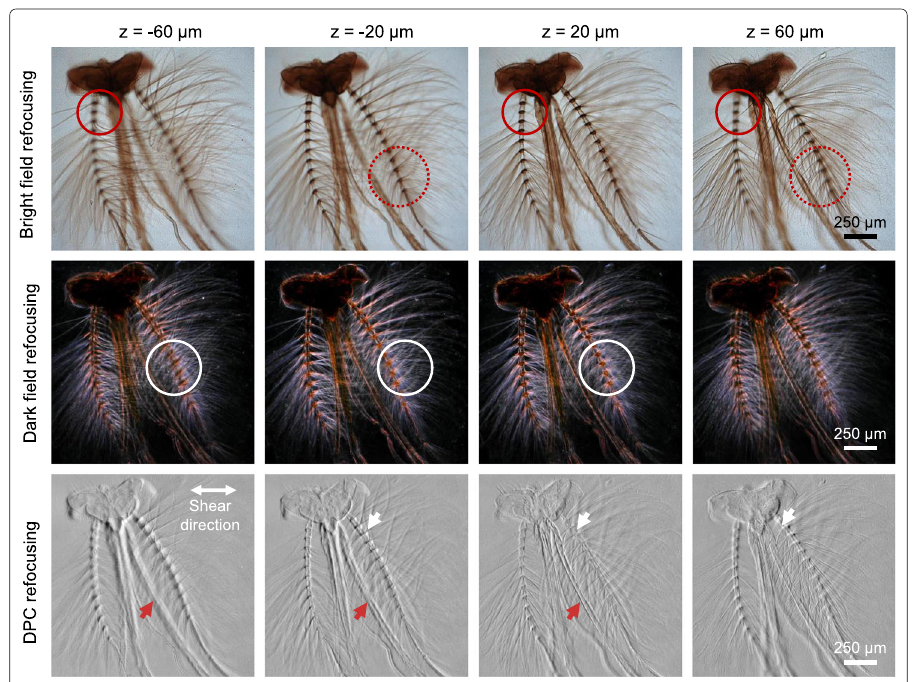
Fig. 14 Refocusing results of mosquito mouthpart specimen in bright field, dark field, DPC at z = − 60 μ m , z = − 20 μ m , z = 20 μ m , z = 60 μ